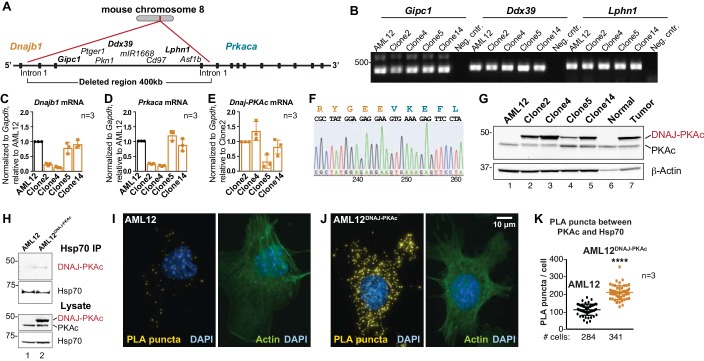
Generation and characterization of AML12DNAJ-PKAc cell lines.(A) CRISPR-Cas9 gene editing of mouse chromosome eight in AML12 cells deleted a 400 kb region between intron 1 of the gene for Hsp40 (Dnajb1) and intron 1 of the gene for PKAc (Prkaca). (B) PCR detection of transcripts for the Gipc1, Ddx39 and Lphn1 genes encoded on the non-engineered strand of mouse chromosome 8. (C–E) Quantitative PCR detection of native mRNA transcripts in AML12 (black) and gene-edited (orange) cell lines. (C) Detection of native Dnajb1 mRNA transcripts, (D) Prkaca transcripts and (E) Dnajb1-Prkaca mRNA transcripts. Data (n = 3) is normalized to Gapdh (C–E) and relative to (C,D) wildtype AML12 or (E) clone 2. Error bars indicate mean ±s.d. (F) Amino acid sequence of the fusion protein DNAJ-PKAc is shown in orange and blue. Nucleotide sequence of the fusion gene from clone 14 AML12DNAJ-PKAc cells is shown below. (G) Immunoblot detection of both native and mutant PKAc in four clonal AML12DNAJ-PKAc cell lines. Top) DNAJ-PKAc fusion proteins (upper bands) and wildtype PKAc (lower bands) are indicated. The distribution of PKAc in wildtype AML12 cells, normal liver and FLC are included. Bottom) Actin loading control. (H) Immunoblot detection of PKA in Hsp70 immune complexes isolated from wildtype (AML12) and clone 14 AML12DNAJ-PKAc cells. Lysate loading controls indicate both forms of PKA (middle) and levels of Hsp70 (bottom). (I and J) Proximity Ligation (PLA) detection of proteins within 40–60 nm of each other in (I) AML12 and (J) AML12DNAJ-PKAc cells. Yellow puncta identify Hsp70-kinase sub-complexes. Actin stain (green) marks cytoskeleton and DAPI staining (blue) marks nuclei. (K) Box-whisker plots of Hsp70-kinase sub-complexes. Amalgamated data (PLA puncta/cell) from AML12 (black) and AML12DNAJ-PKAc (orange) cells. Number of cells analyzed over three independent experiments is indicated below each plot; data are shown as mean ±s.d., p<0.0001 by Student’s t-test (t = 14.16, df = 105).